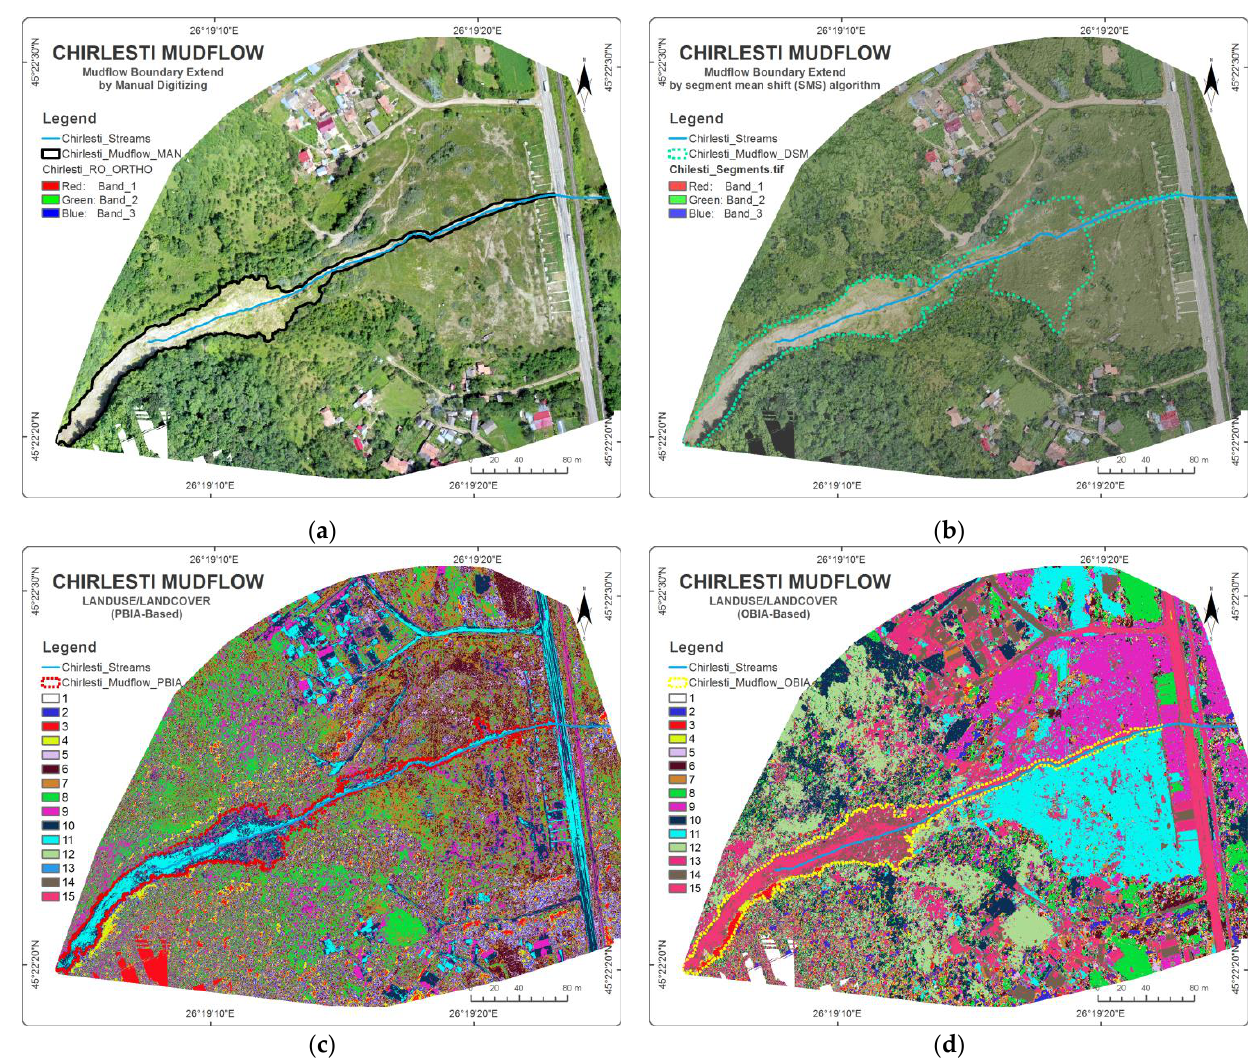
(Table 4). For the Chirlesti mudflow study site, Student’s t-test analysis revealed a statistical significance ( p < 0.05) among the four classifications in both the perimeter and area. Because degraded and deposited areas may be better seen in DSM images than in the orthoimage (Figures 6c and 12), the DSM-based classification of the mudflow site differed from the manual digitization by 91% (Table 4).